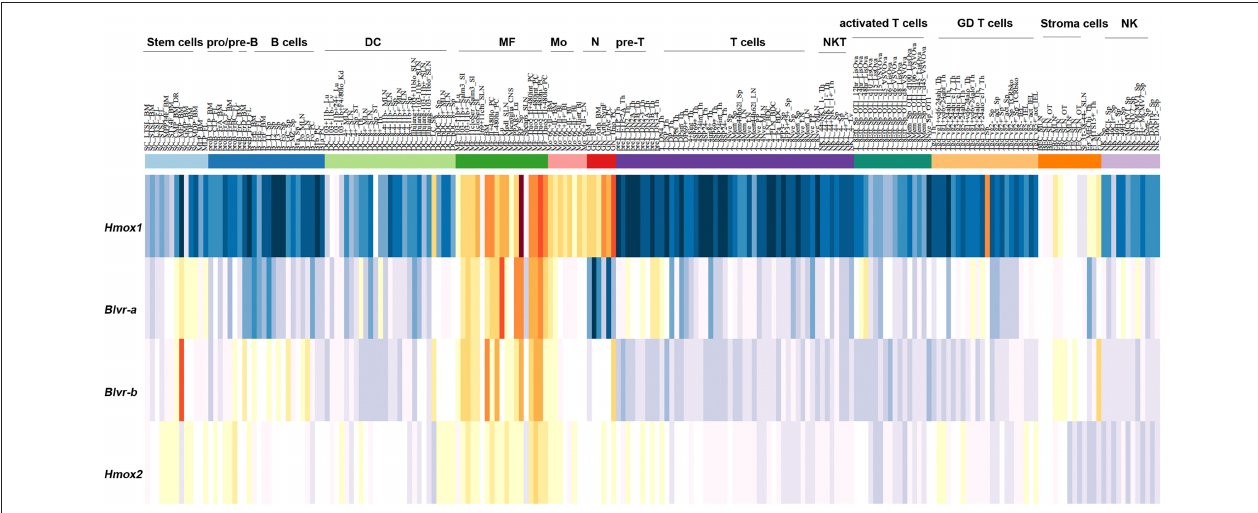
FIGURE 3 | Expression pattern of HMOX1, HMOX2, BLVR-A, and BLVR-B mRNA in immune cells as reported in the ImmGen expression data software (http://rstats. immgen.org/MyGeneSet).